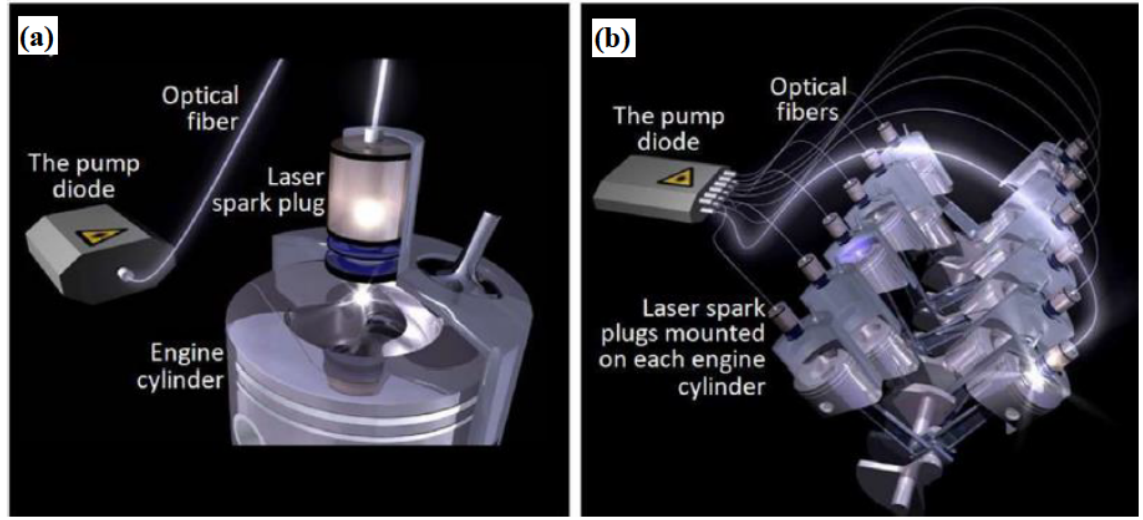
Figure 13: Computer illustration of an end-pumped by fiber-coupled diode lasers, passively Q-switched solid-state laser with pump diode positioned apart from the engine and the laser head mounted directly on the engine cylinder (a) [7] and on a 12-cylinder internal combus- tion engine (b) [8].